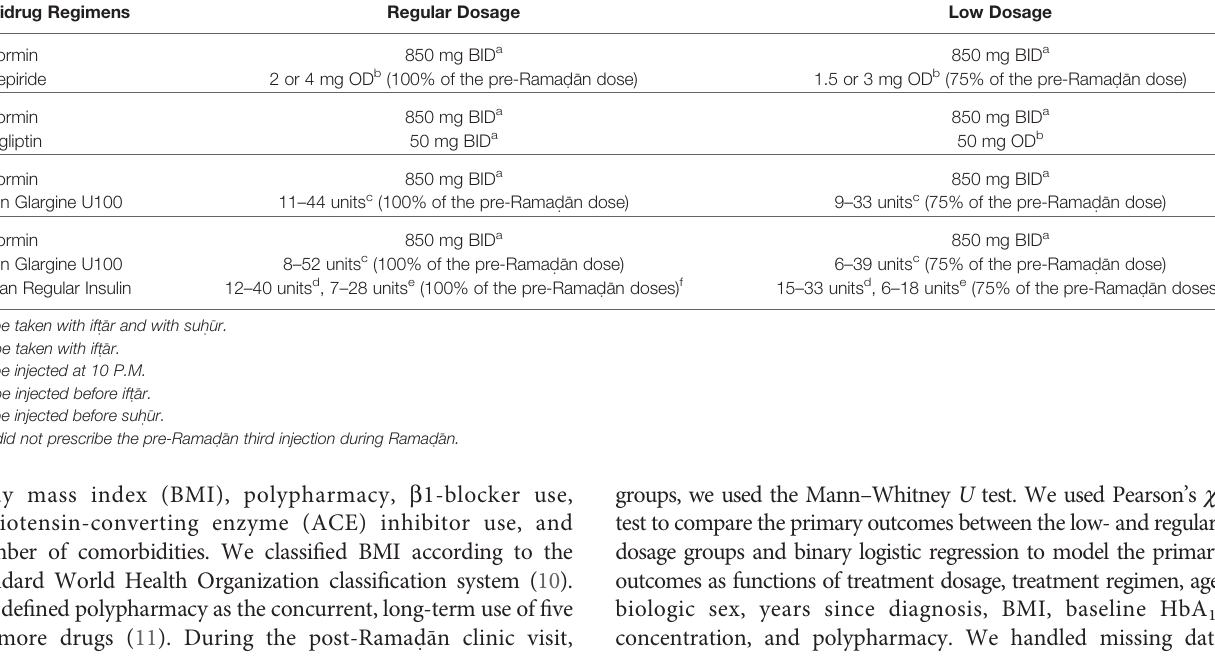
TABLE 1 | The hypoglycemic multidrug regimens used during Ramad ̣ a ̄ n by our participants, who we randomly allocated to low- or regular-dosage therapy ( N = 678 participants). Multidrug